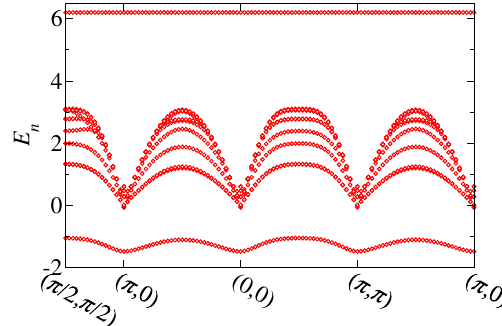
FIG. 18. Energy levels versus the total wave vector of two spinons interacting through a potential V ð r Þ ¼ − 6 . 2 e − r= 2 . The bare dispersion relation of the single spinon is given by Eq. (21) with c s ¼ 3 . 1 . We only show a few of the levels between the lower and higher energy